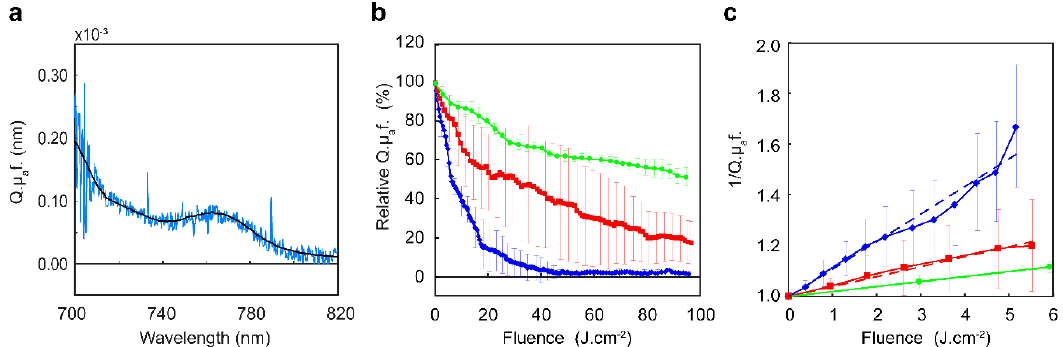
Figure 6. Fluorescence measurements during PDT using different fluence rates. ( a ) Example of a collected fluorescence spectrum recorded during illumination (azure blue) and the IRDye700DX basis spectrum (black). ( b ) Weighted mean intrinsic fluorescence intensity determined during PDT at 20 mW·cm − 2 (blue diamonds), 50 mW·cm − 2 (red squares), and 150 mW·cm − 2 (green circles). ( c ) Weighted mean of reciprocal of normalized fluorescence during the first 5 J·cm − 2 delivered at 20 mW·cm − 2 (blue diamonds), 50 mW·cm − 2 (red squares), and 150 mW·cm − 2 (green circles) and their corresponding linear regression line.